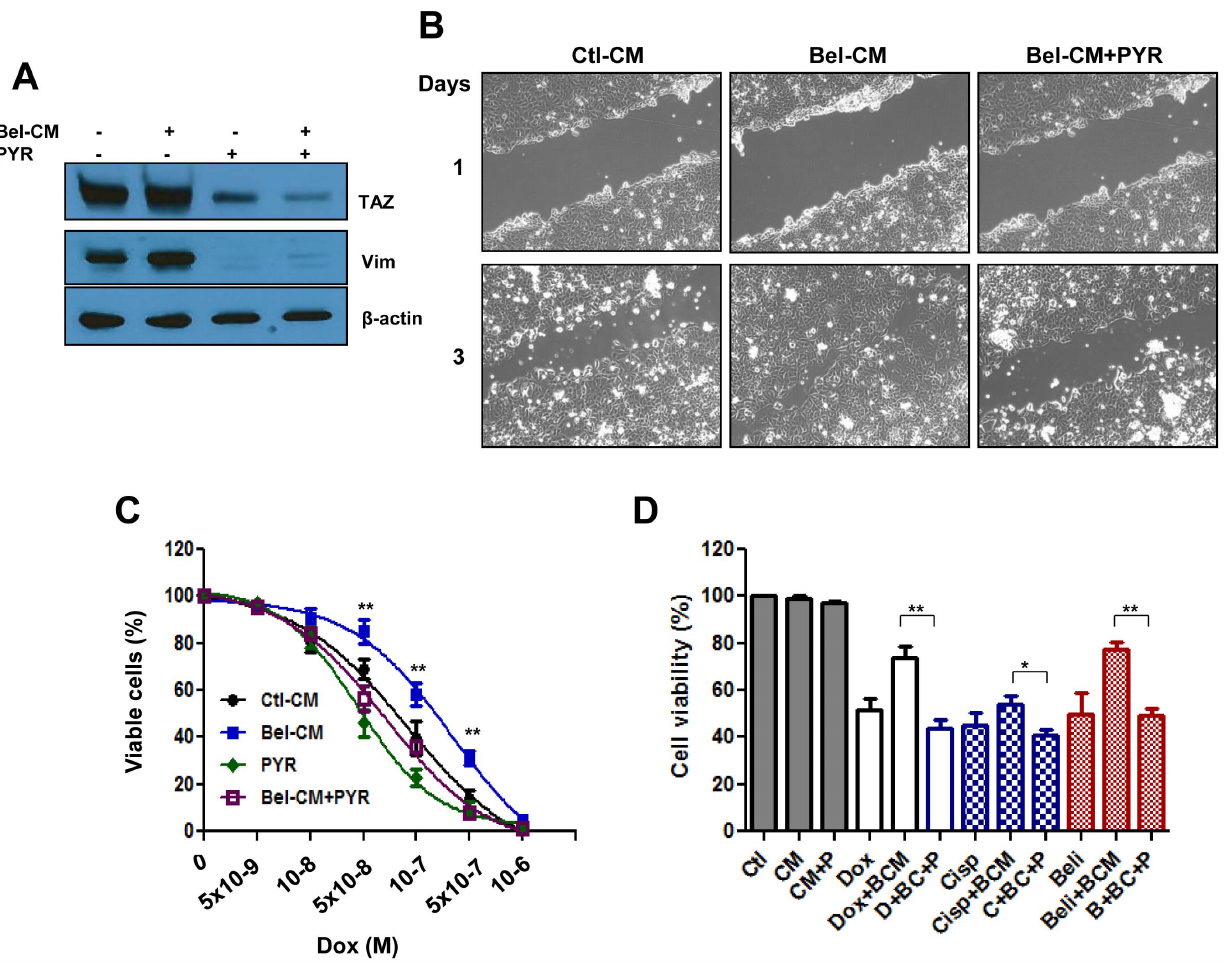
Figure 6. Targeting the GSK 3 beta associated destruction complex reduces TAZ levels, cancer cell migration and resistance to therapy. Panel A. Naı¨ve SW480 cells were exposed to conditioned medium from Belinostat (1 m M) treated counterparts (Bel-CM), in the absence or the presence of Pyrvinium (PYR) at 0.5 m M. After 24 hours, the cells were processed for Western blot with antibodies to TAZ, Vimentin (Vim) and beta actin. Panel B. Monolayer scratch assay depicting the effect of Bel-CM on cell migration and its delay by pyrvinium. MCF cells cultured until confluency and scratches introduces in the monolayer using a pipette tip. The cells were then incubated in the presence or absence of Bel-CM, with or without pyrvinium (0.5 m M) for the indicated times, representative photographs are shown. Panel C. Effect of Bel-CM and pyrvinium of cellular response to doxorubicin. SW480 cells were incubated with doxorubicin at the indicated concentration in absence or presence of Bel-CM, Pyrvinium (PYR) or both. Cell viability was determined by MTT assay as described in the Methods section and the data represented as per cent of control non-treated cells. The data represent average of three determinations 6 SE. Statistical significance is shown for Bel-CM exposed cells in the absence or the presence of PYR (**p , 0.001). Panel D. Effect of PYR on cellular response to other drugs. Cells were exposed to the indicated drugs in the absence or presence of Bel- CM (BCM) and pyrvinium (P). Cell viability was determined by MTT assay after 72 hours in culture. The data represent average of three determinations 6 SE. Statistical significance is shown for Bel-CM exposed cells in the absence or the presence of PYR for each drug tested (*p , 0.05, **p ,